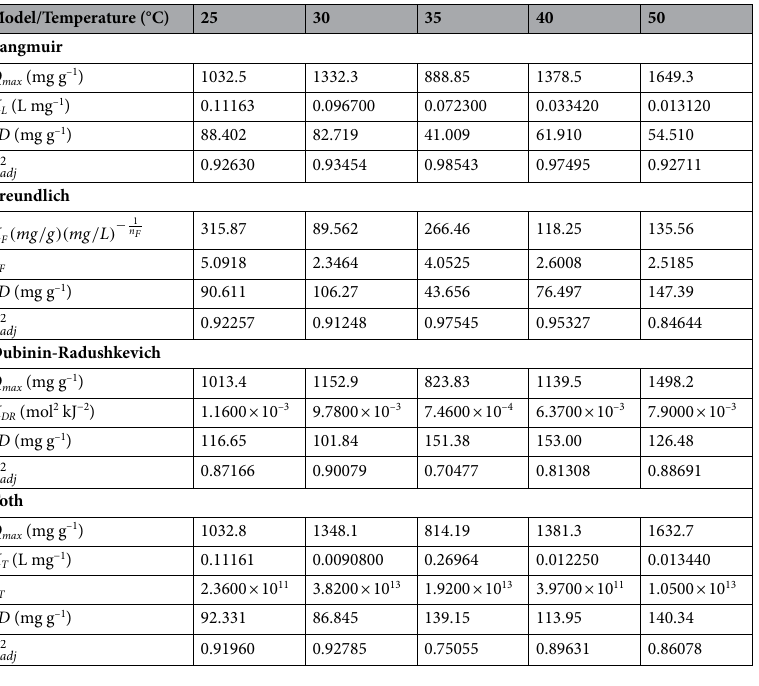
Table 2. Equilibrium parameters of adsorption of Congo red by CHCFe. Conditions: initial pH of the solution = 2; mass of adsorbent = 0.05 mg; temperature = 25–50 °C; agitation time = 1 h; initial concentration of Congo red = 0.02–3 g L –1 ; volume of Congo red = 20 mL; and agitation speed = 160 rpm.